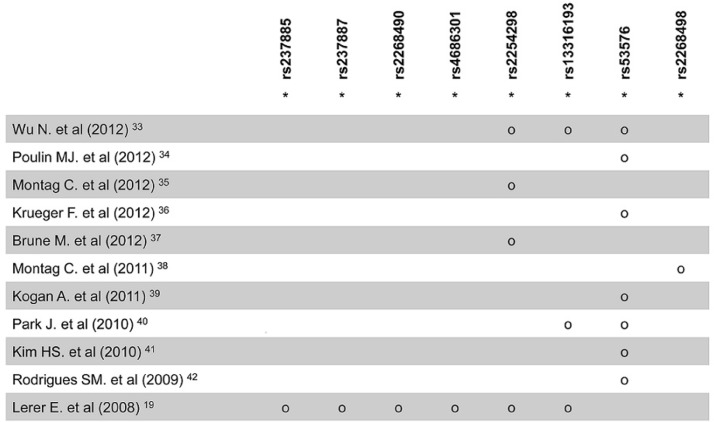
Selection of OXTR single-nucleotide polymorphism (SNP).Circle denote SNPs significantly associated with prosocial behavior in single-marker analyses of previous studies, with asterisks representing SNPs included the current association study.